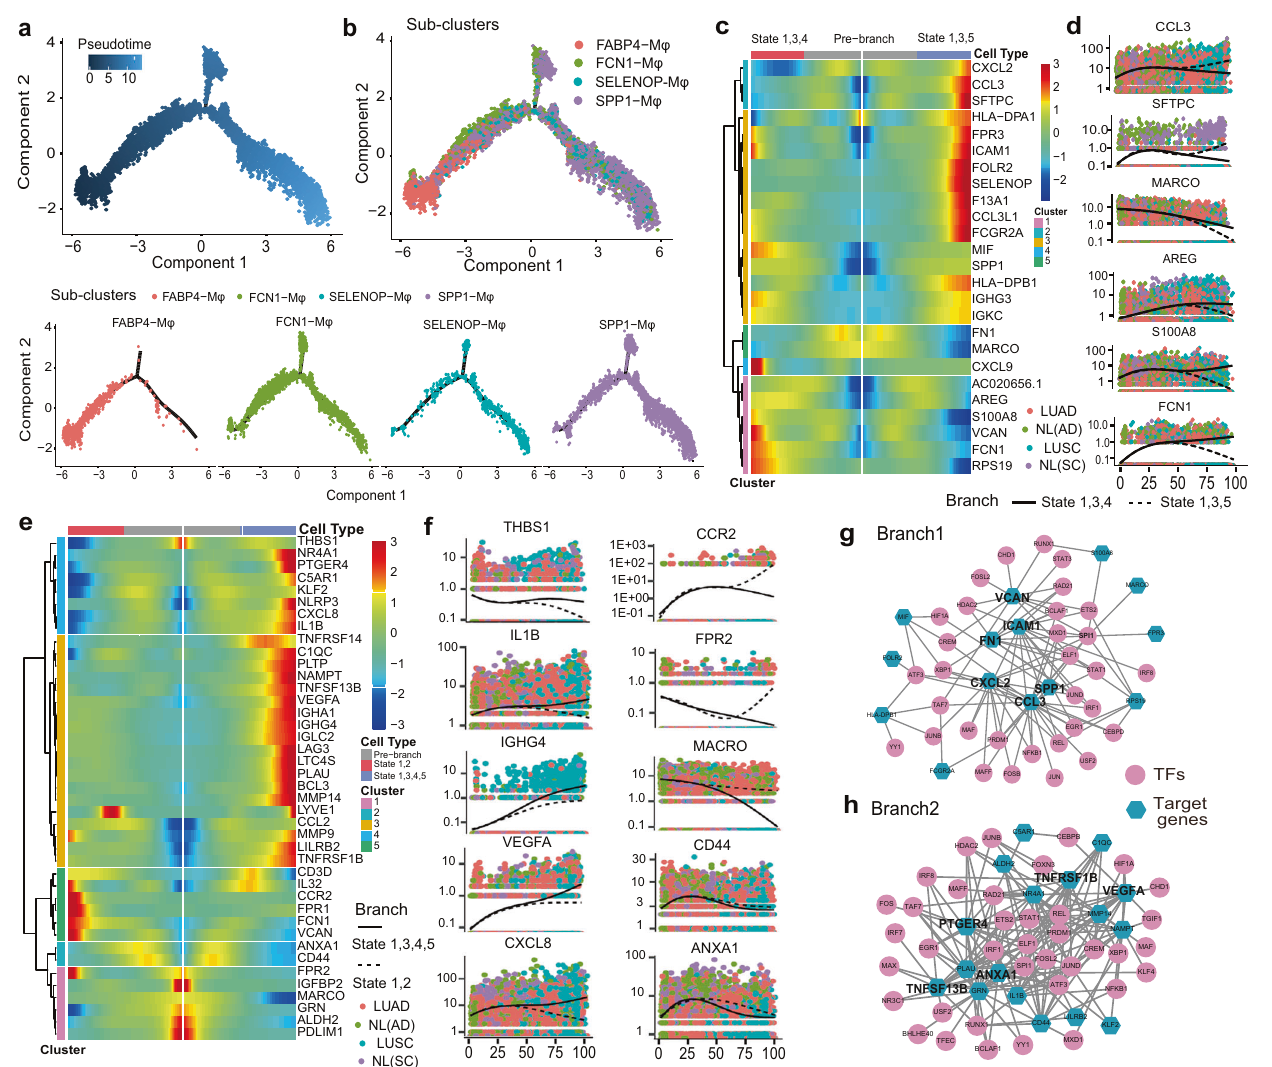
Fig. 6 The trajectory analysis of M φ in LUAD and LUSC revealed distinct features. a , b Differentiation trajectory of M φ in all lung samples, with each point colored by pseudotime ( a ) and M φ subtype ( b ) (bottom) which was divided into two branches. c , d Pseudo-heatmap showing the various genes in the differentiation process of M φ in branch 1, which was clustered into fi ve clusters, and a scatter distribution plot showing the expression variation of some speci fi c genes in each state during the pseudotime. The fi t curves representing the gene expression of two states, and color coded for cancer type. e , f Pseudo-heatmap showing the various genes involved in the differentiation process of M φ in branch 2, which was clustered into fi ve clusters, and the scatter distribution plot showed the expression variation of some speci fi c genes in each state during the pseudotime. The fi t curves represent the gene expression of two states, and color coded for cancer types. g , h Ligand – receptor connections network among TFs and their target genes in branch 1 ( g ) and branch 2 ( h )